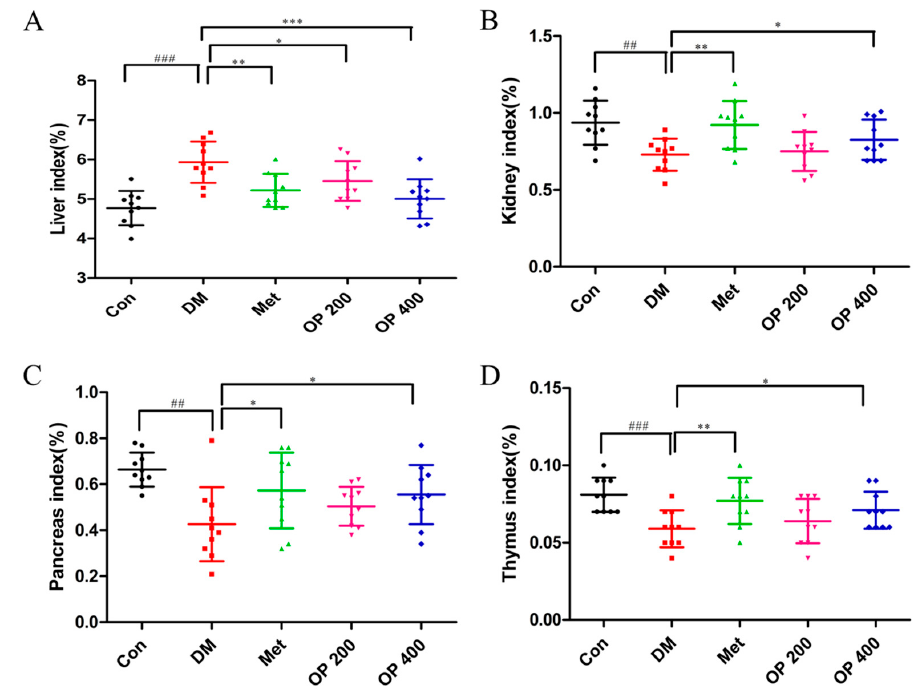
Figure 3. Effects of OP on organ index of whole experimental mice. ( A ) Liver index; ( B ) kidney index; ( C ) pancreas index; ( D ) thymus index. Data represent means ± standard error of the mean (SEM; n = 10). ## p < 0.01, ### p < 0.001 vs. control, * p < 0.05, ** p < 0.01, *** p < 0.001 vs. model.